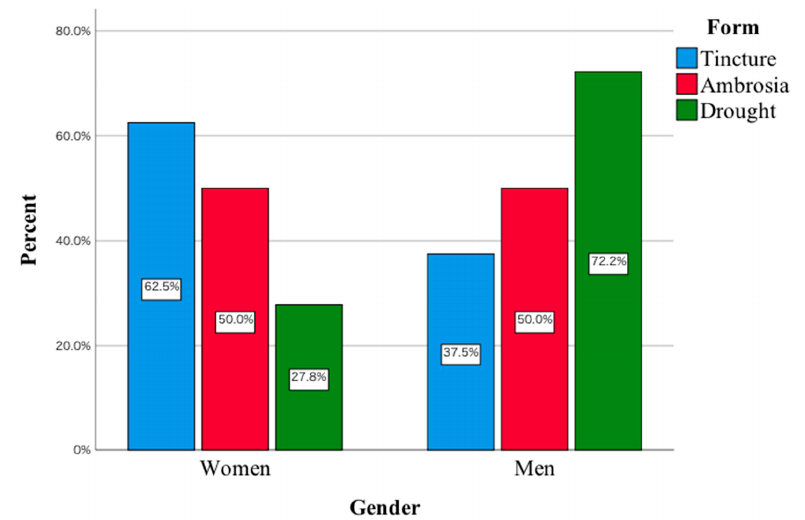
Figure 2. Form of consumption of Amanita muscaria in the study group women and men.